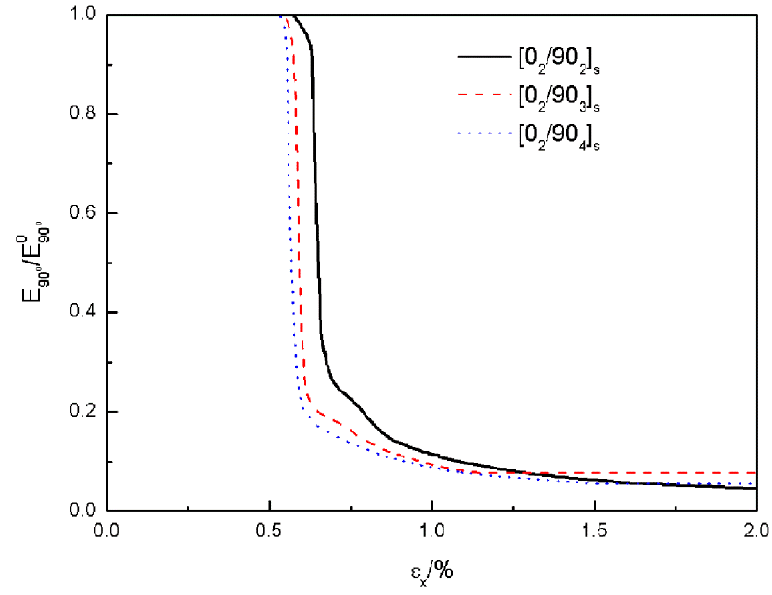
Figure 13. The relationship between the transverse ply strength and transverse ply thickness.